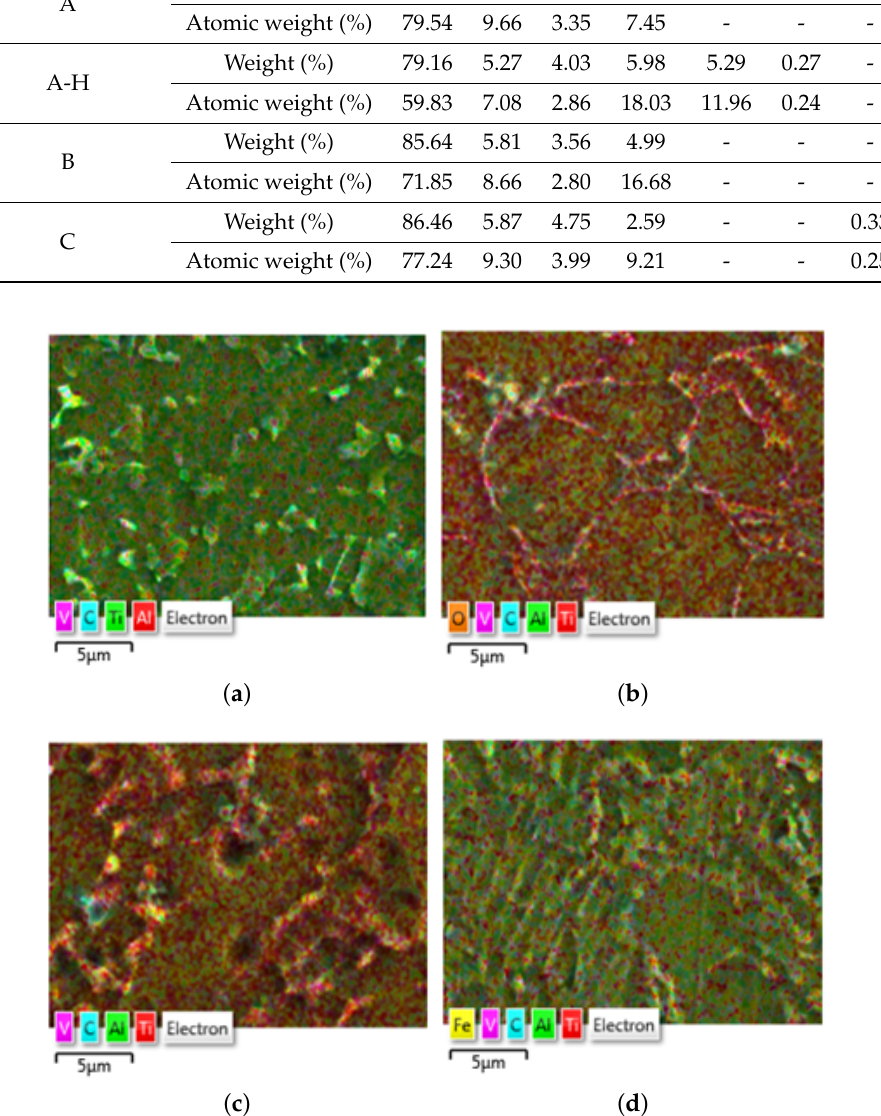
Figure 16. EDS layered image. ( a ) Material sample A; ( b ) Material sample A-H; ( c ) Material sample B; ( d ) Material sample